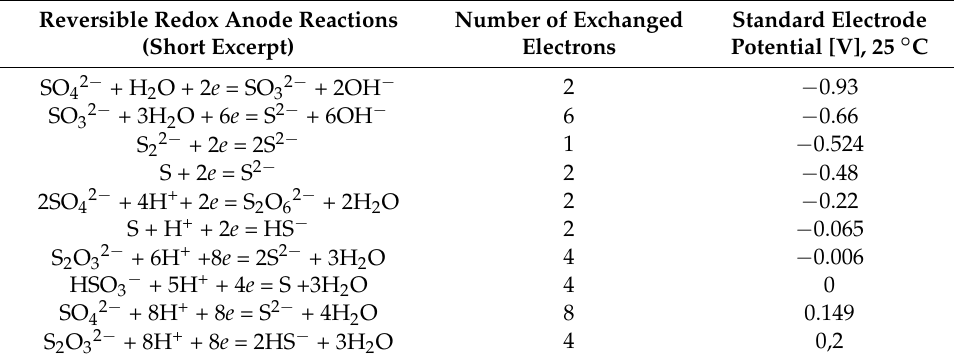
Table 3. Short excerpt of sulfide oxidation reactions, from Reference